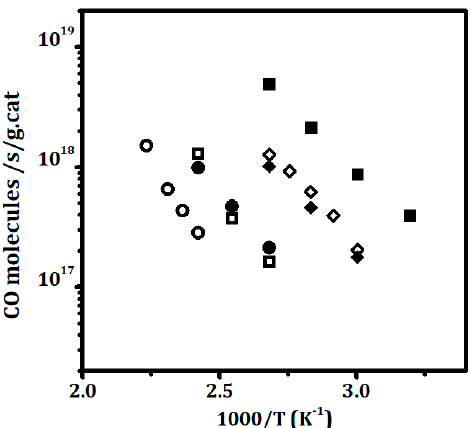
Figure 3. Steady-state, differential reaction rates for CO oxidation reaction with partial pressure of CO and O 2 at 25 Torr and 12.5 Torr, respectively. The supports were heated at 1073 K in air for 2 h before 1 wt % of Pd was introduced. After calcination at 773 K in air, the CO oxidation rates were compared for the following catalysts: ( ○ )—Pd/Al 2 O 3 , ( □ )—Pd/CeO 2 (IMP)/Al 2 O 3 , ( ● )—Pd/CZ(IMP)/Al 2 O 3 , ( ) θ —Pd/20Ce 0.5 Zr 0.5 O 2 –Al 2 O 3 , and ( ∎ ) Pd/20CeO 2 –Al 2 O 3 . The catalyst, ( ◊ )—